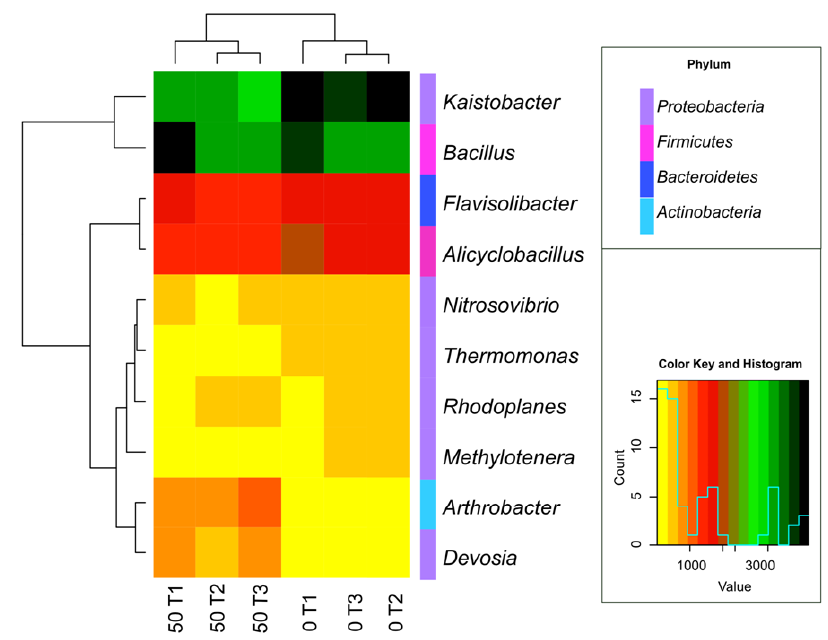
Figure 10. Heat map and associations of the number of bacterial genus in soil with a difference between proportions ≥1%. 0; 50—doses of o-cresol (mg kg −1 DM of soil); T1—15 th day, T2—30 th day, T3—45 th day of the experiment.